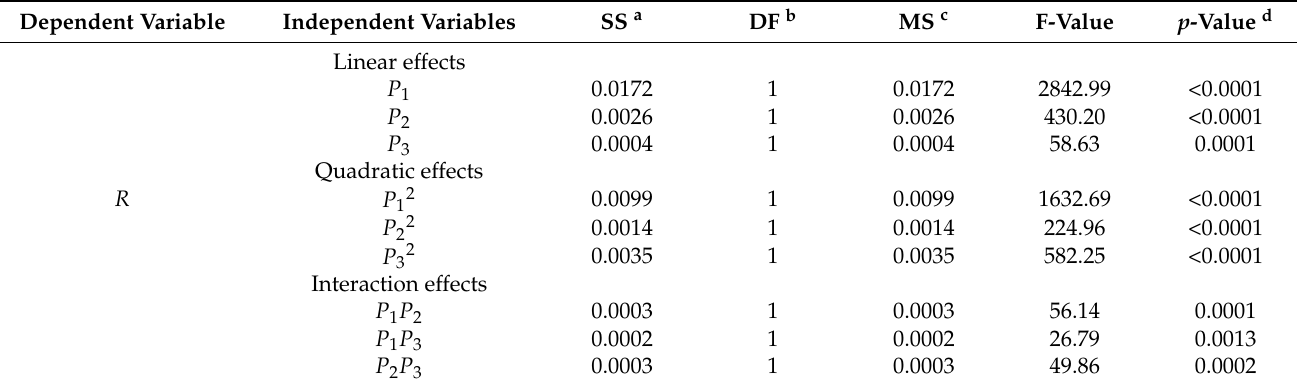
Table 5. The significance of each response variable effect shown by using the F ratio and p -value in the nonlinear second- order